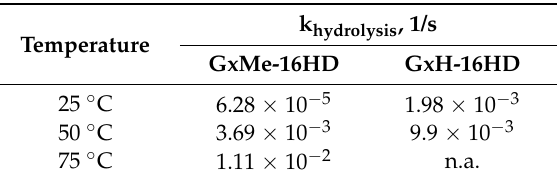
Table 4. Apparent kinetic constants of the hydrolysis of GxMe-16HD respectively GxH-16HD in citric acid 5% at 25, 50 and 75 ◦ C.